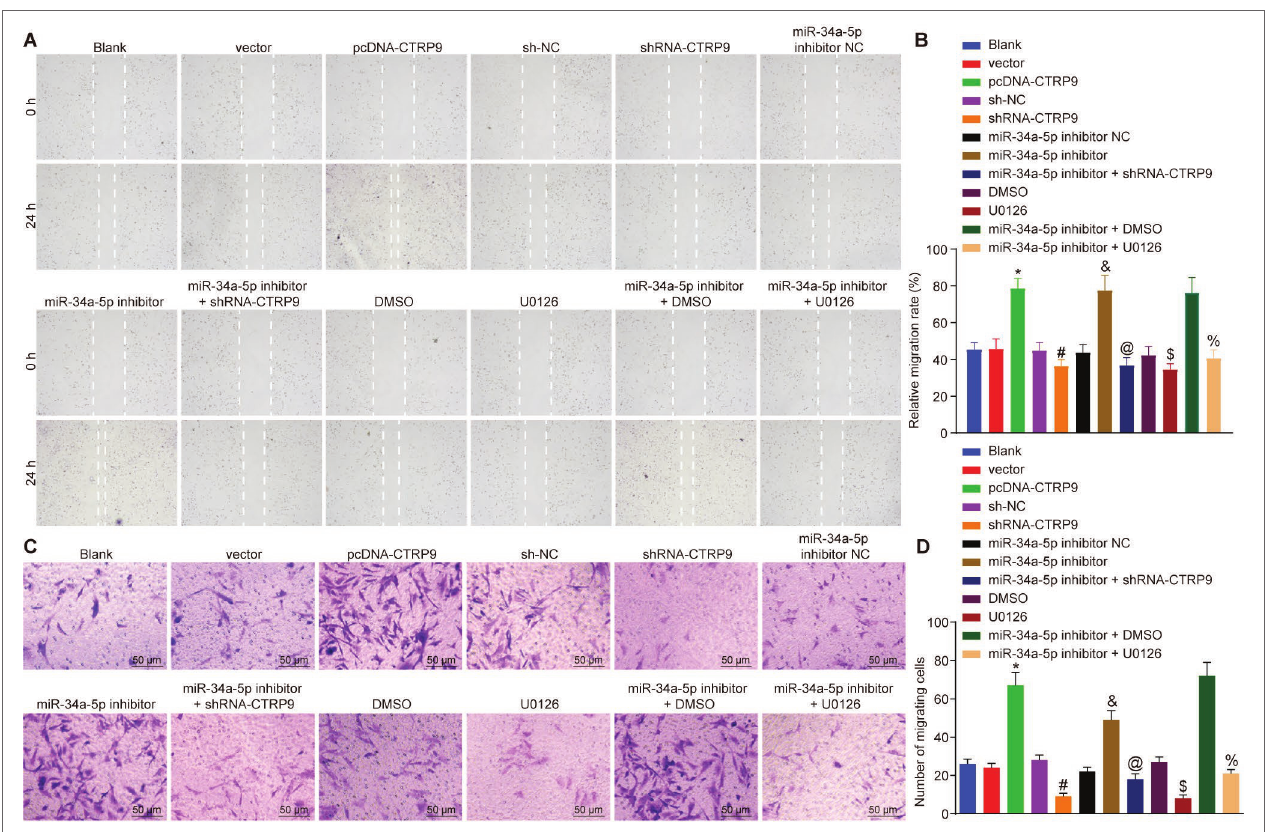
FIGURE 4 | Inhibition of miR-34a-5p promotes ADSC migration in vitro by up-regulating CTRP9. (A,B) Cell migration after transfection detected by the scratch test. (C,D) Cell migration after transfection detected by Transwell assay (200 ×). * p < 0.05 vs. the vector group; # p < 0.05 vs. the sh-NC group; & p < 0.05 vs. the miR-34a-5p inhibitor NC group; @ p < 0.05 vs. the miR-34a-5p inhibitor group; $ p < 0.05 vs. the DMSO group; % p < 0.05 vs. the miR-34a-5p inhibitor + DMSO group. Data (mean ± s.d.) among multiple groups were analyzed by one-way ANOVA, followed by Tukey’s post hoc test. Log-rank was used for univariate analysis. The experiment was repeated three times. CTRP9, C1q/tumor necrosis factor-related protein-9; miR-34a-5p, microRNA-34a-5p; ADSC, adipose-derived stem cell; sh, short hairpin; NC, negative control; DMSO, dimethyl sulfoxide; s.d., standard deviation; ANOVA, analysis of